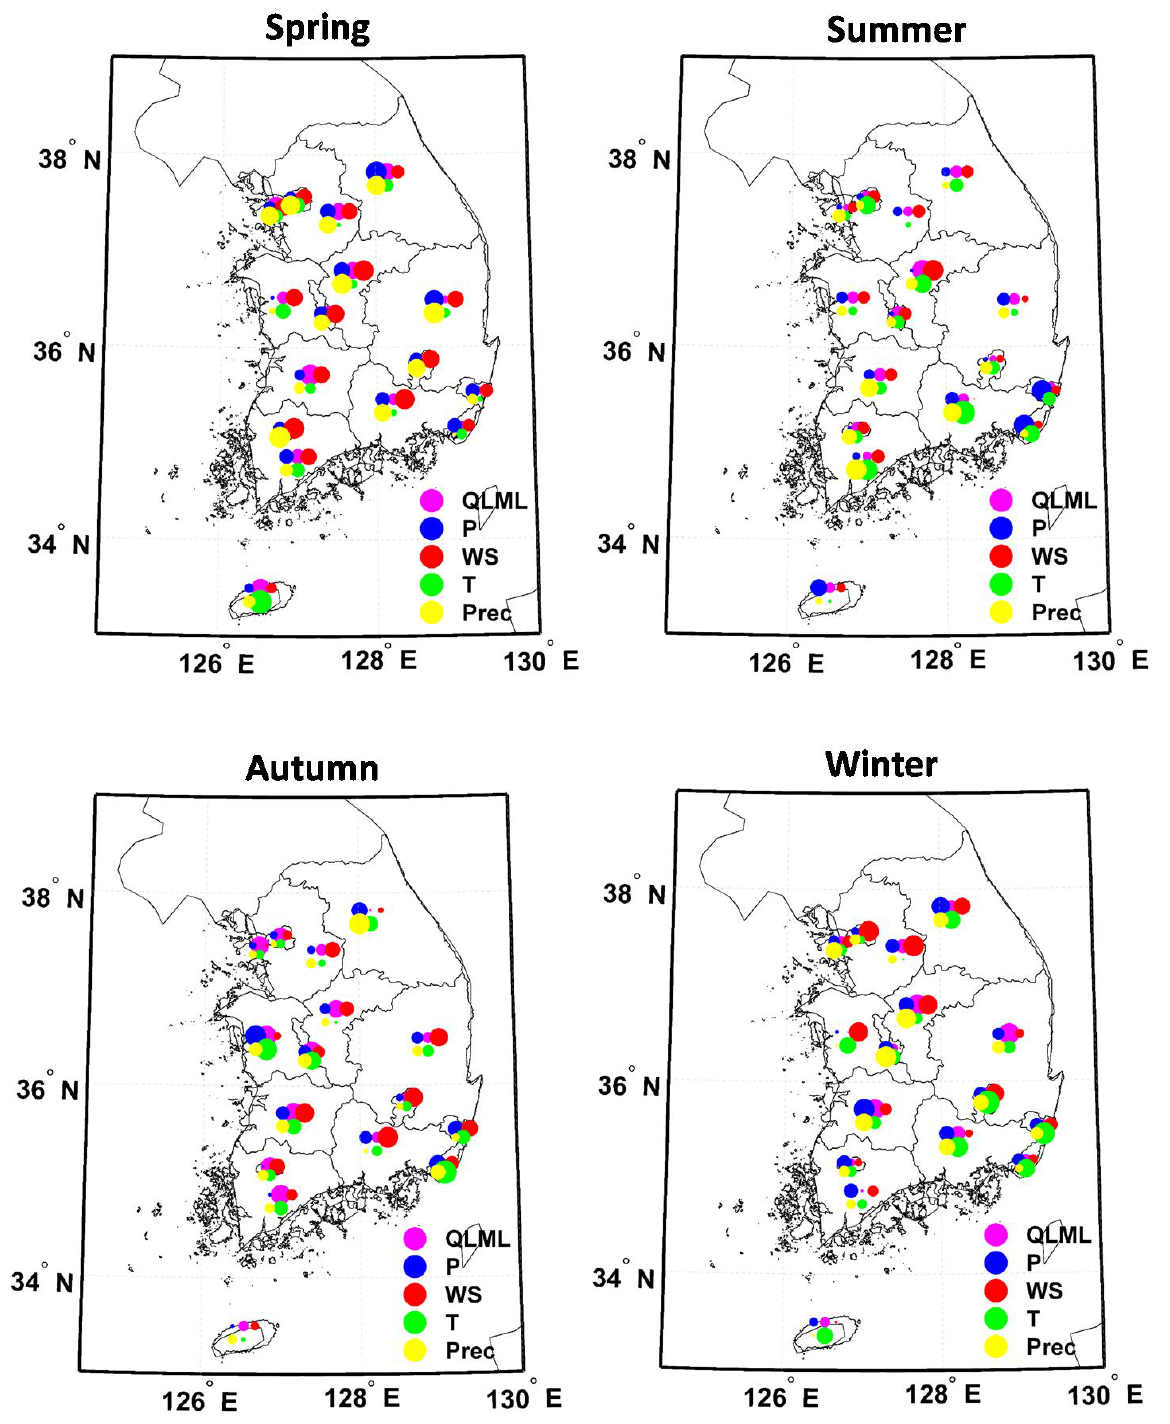
Figure 13. MLR model results between PM 2.5 and the meteorological parameters. The colors represent the type of the meteorological parameter, and the size indicates the magnitude of the influencing parameter. R 2 represents the fitting effect of the model, the F-test determines the significance of the model, and the t-test determines the significance of the independent variables.